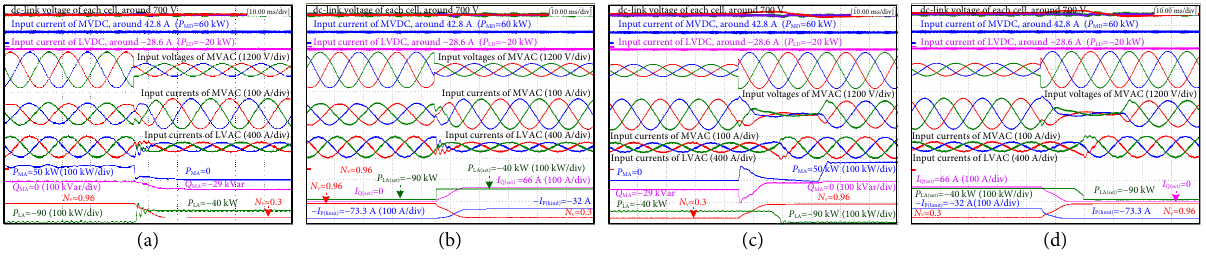
dc-link voltage of each cell, around 700 V Input current of MVDC, around 42.8 A ( P MD ≈60 kW) Input current of LVDC, around −28.6 A ( P LD ≈−20 kW)